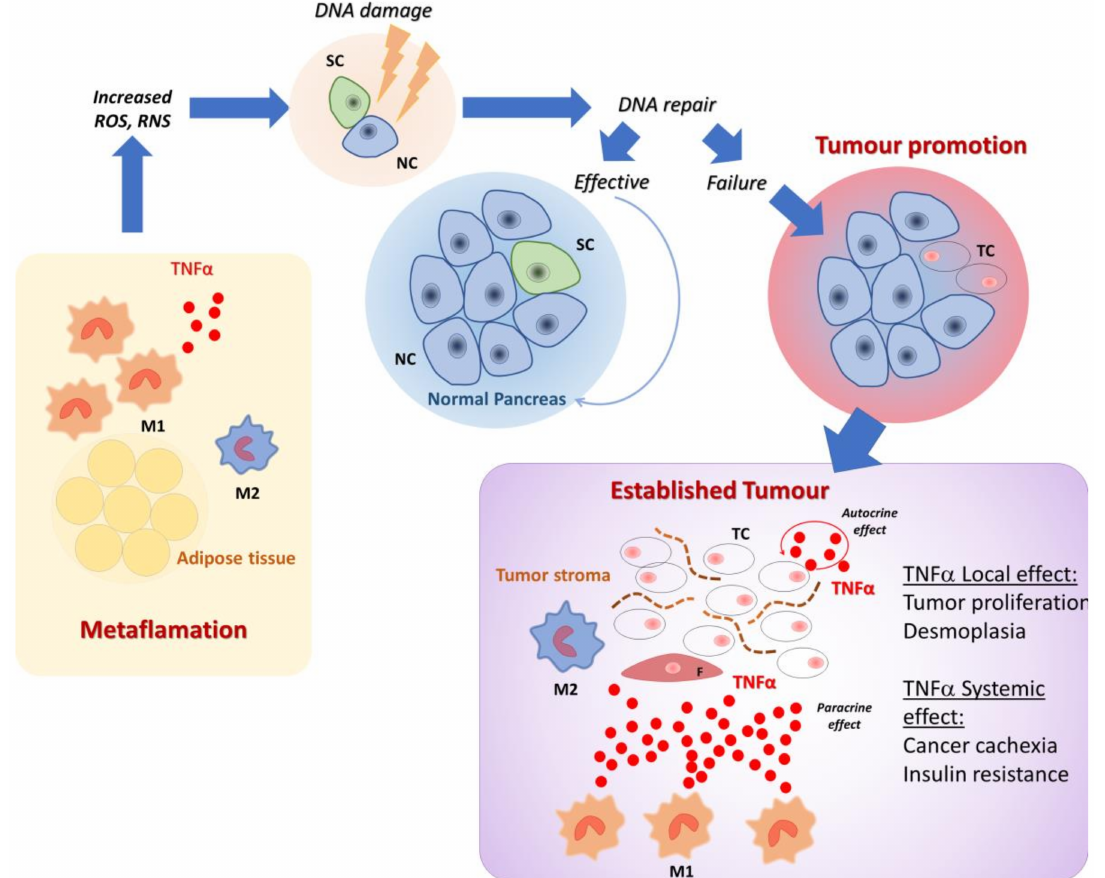
Figure 1. Tumor necrosis factor alpha (TNF α ) role in tumor promotion and in tumor-associated inflammation. In adiposity-associated systemic inflammation (metaflammation), pro-inflammatory M1 macrophages infiltrate the adipose tissue prevailing over M2 macrophages. Low amounts of TNF α , produced by M1 macrophages, might cause DNA damage by inducing reactive oxygen (ROS) and nitrogen (RNS) species. When normal pancreatic ductal cells (NC), but mainly stem cells (SC) are targeted, the failure of DNA repair after damage results in the clonal expansion of tumor cells (TC) and tumor establishment. Within the tumor microenvironment, made of stroma, tumor-associated fibroblasts (F), and inflammatory cells, including M1 and M2 macrophages, TNF α is produced by both TC and M1 macrophages. TNF α exerts effects on TC, inducing proliferation; on F, inducing stroma production and desmoplasia; and on distant sites concurring in causing cancer-associated cachexia and insulin